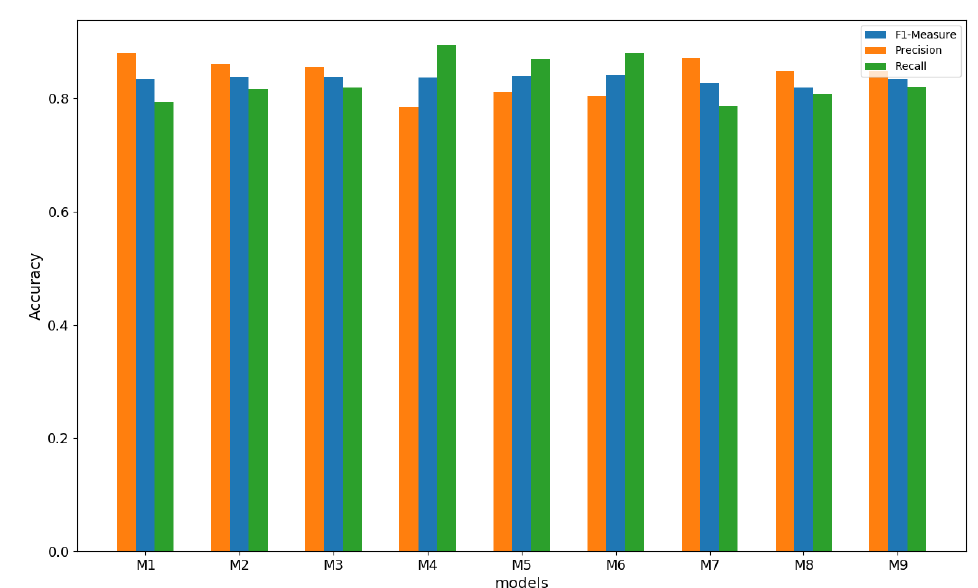
Figure 12. Model results.